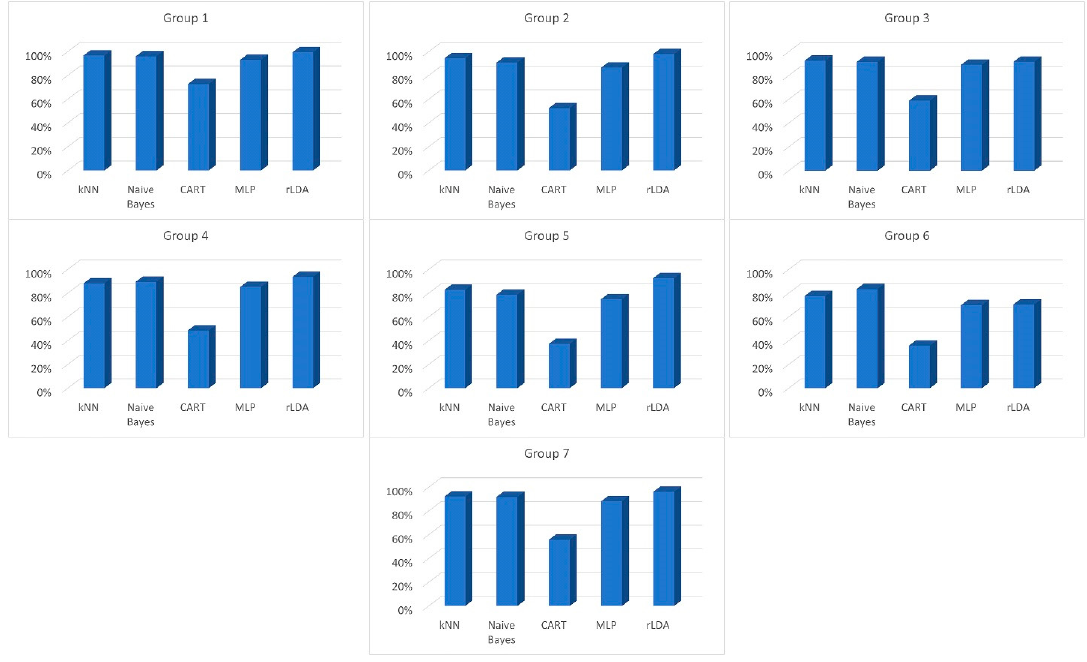
Figure 3. Correct Classification Rate (%) of base classifiers for each group of features. Table 2. Classification results for individual classifiers with Group 1 attributes.